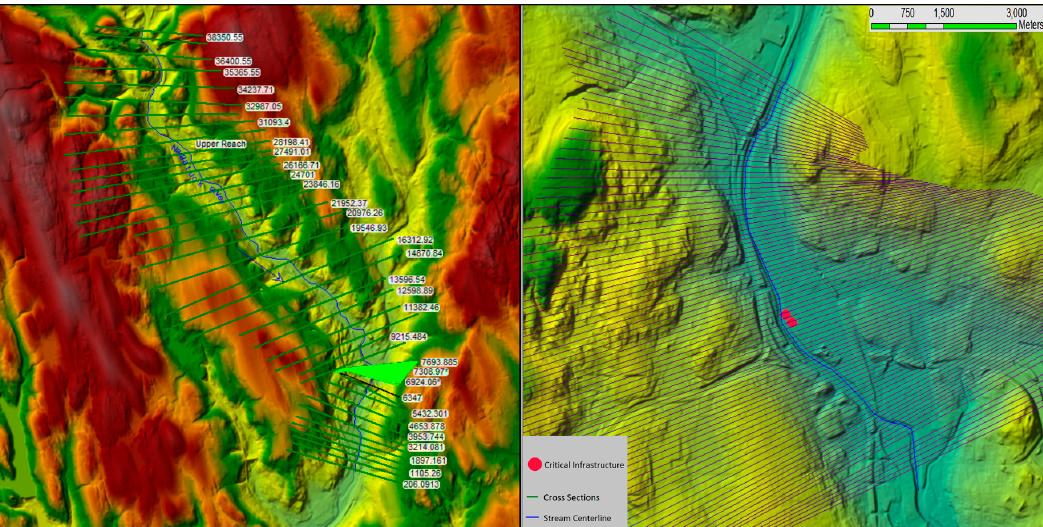
Figure 4. Upstream river reach “U” and downstream river reach “D” modeled in the HEC-RAS domain displayed over LIDAR derived DEM.